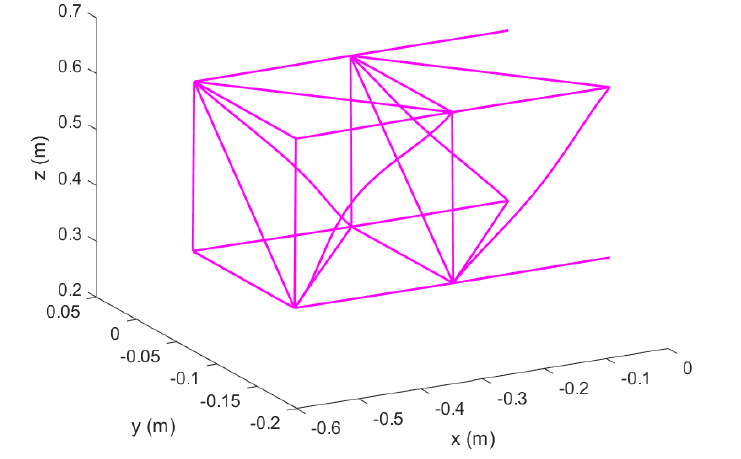
Figure 15. Mode 5 of Euler–Bernoulli Beams in Topology 1 with no hinged ends; original configuration.